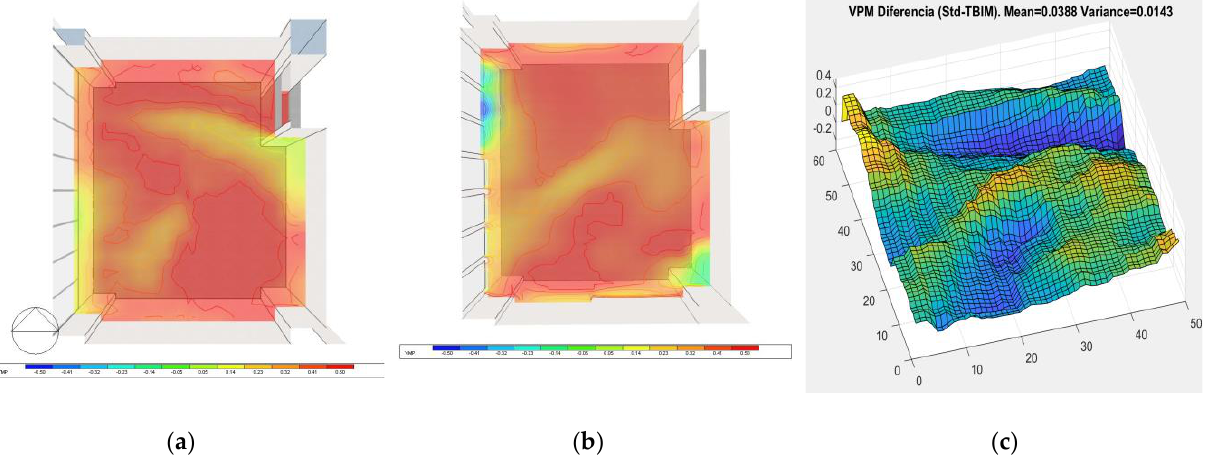
Figure 19. 2D graph maps of PMV comfort values on the horizontal plane at Z = 1.50 m, obtained by CFD simulation of atmospheric air flows, according to the conditions of Room W1, at 17 h, on 19NovemberTMY 2007 – 2021: ( a ) PMV of the as-is STD model; ( b ) PMV of the as-is T-BIM model; and ( c ) Point-to-point resolution of PMV differences in a comparison between both models.